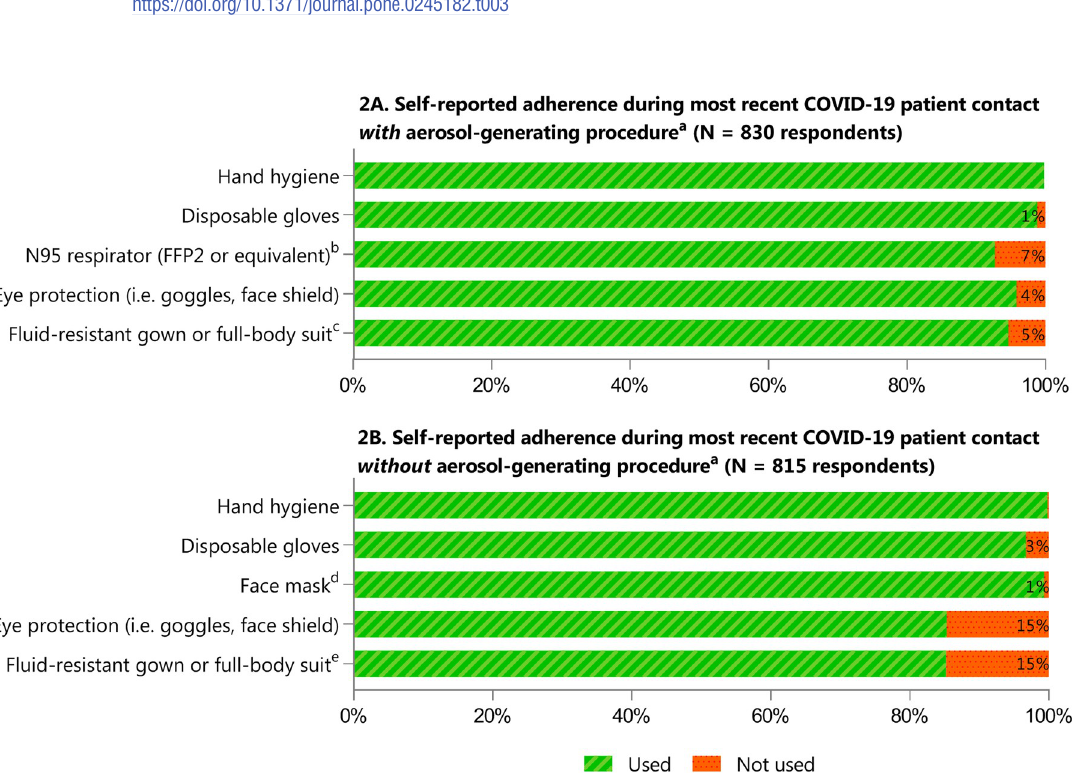
Fig 2. Self-reported adherence to recommended IPC procedures a used during most recent clinical contact with COVID-19 case. a Recommended infection prevention and control (IPC) procedures during direct medical care with suspected or confirmed COVID-19 patients according to WHO interim guidance document (6 April 2020) [26] on the rational use of personal protective equipment (PPE) at the time of data collection: (A) contacts with aerosol-generating procedures (e.g. tracheal intubation, non-invasive ventilation, cardiopulmonary resuscitation): Gloves, N95 mask or equivalent, eye protection (i.e. goggles or face shield), and fluid-resistant long- sleeved gown. (B) Contacts without aerosol-generating procedure: Gown, gloves, medical mask and eye protection (goggles or